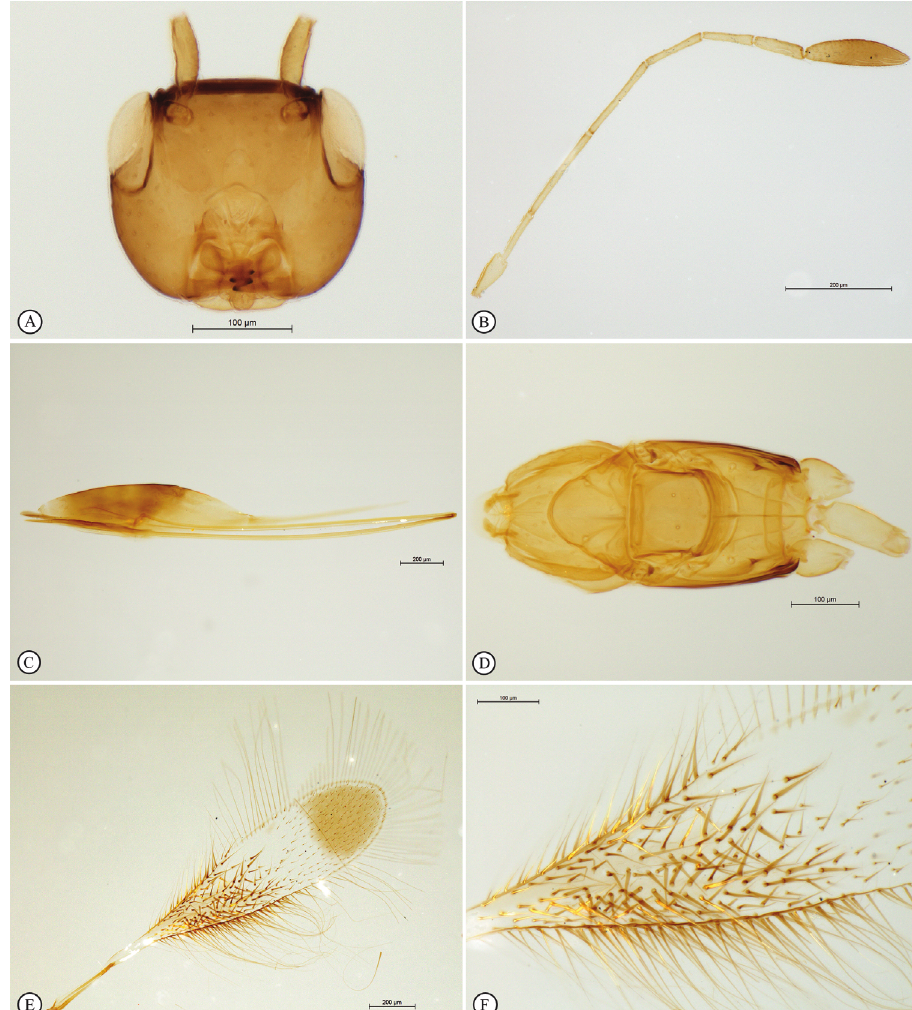
Figure 3. Polynema sagittaria Paratype female, slide-mounted. A Head, anterior view B Antenna, lateral view C Metasoma, lateral view D Mesosoma and petiole, dorsal view E Fore wing, dorsal view F Fore wing discal microtrichia, dorsal